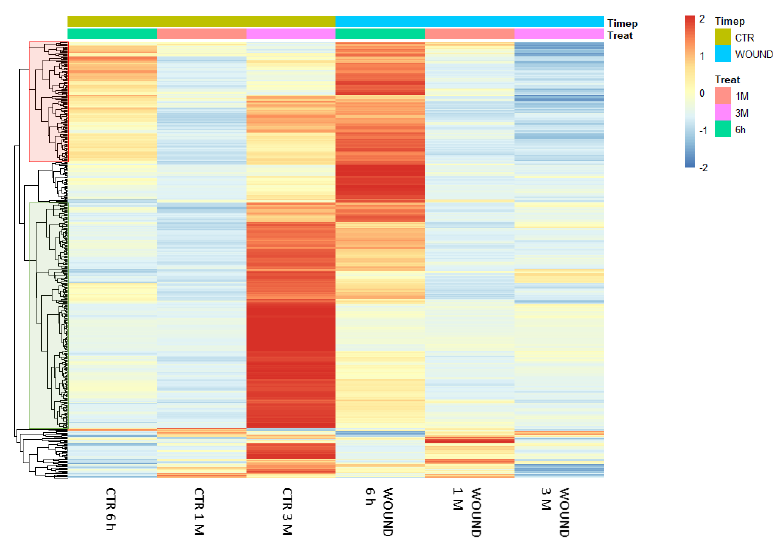
Figure 5. Heatmap showing the expression patterns of 448 differentially expressed genes in the treatment x time interaction analysis in wounded and control tissues of Granny Smith apples. Red and blue colours represent an increase or decrease in the gene expression levels, respectively. DEGs were identified as significantly differentially expressed with an adjusted p -value of <0.01 out of 28313 genes with nonzero total read counts using DESeq2. The data refer to samples collected in 2019.